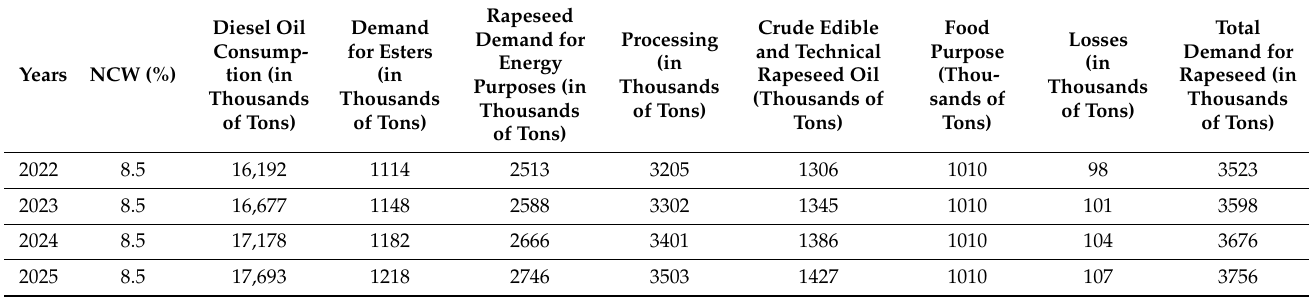
Table 2. Assumptions for the scenario of an increase in demand for rapeseed by 3%